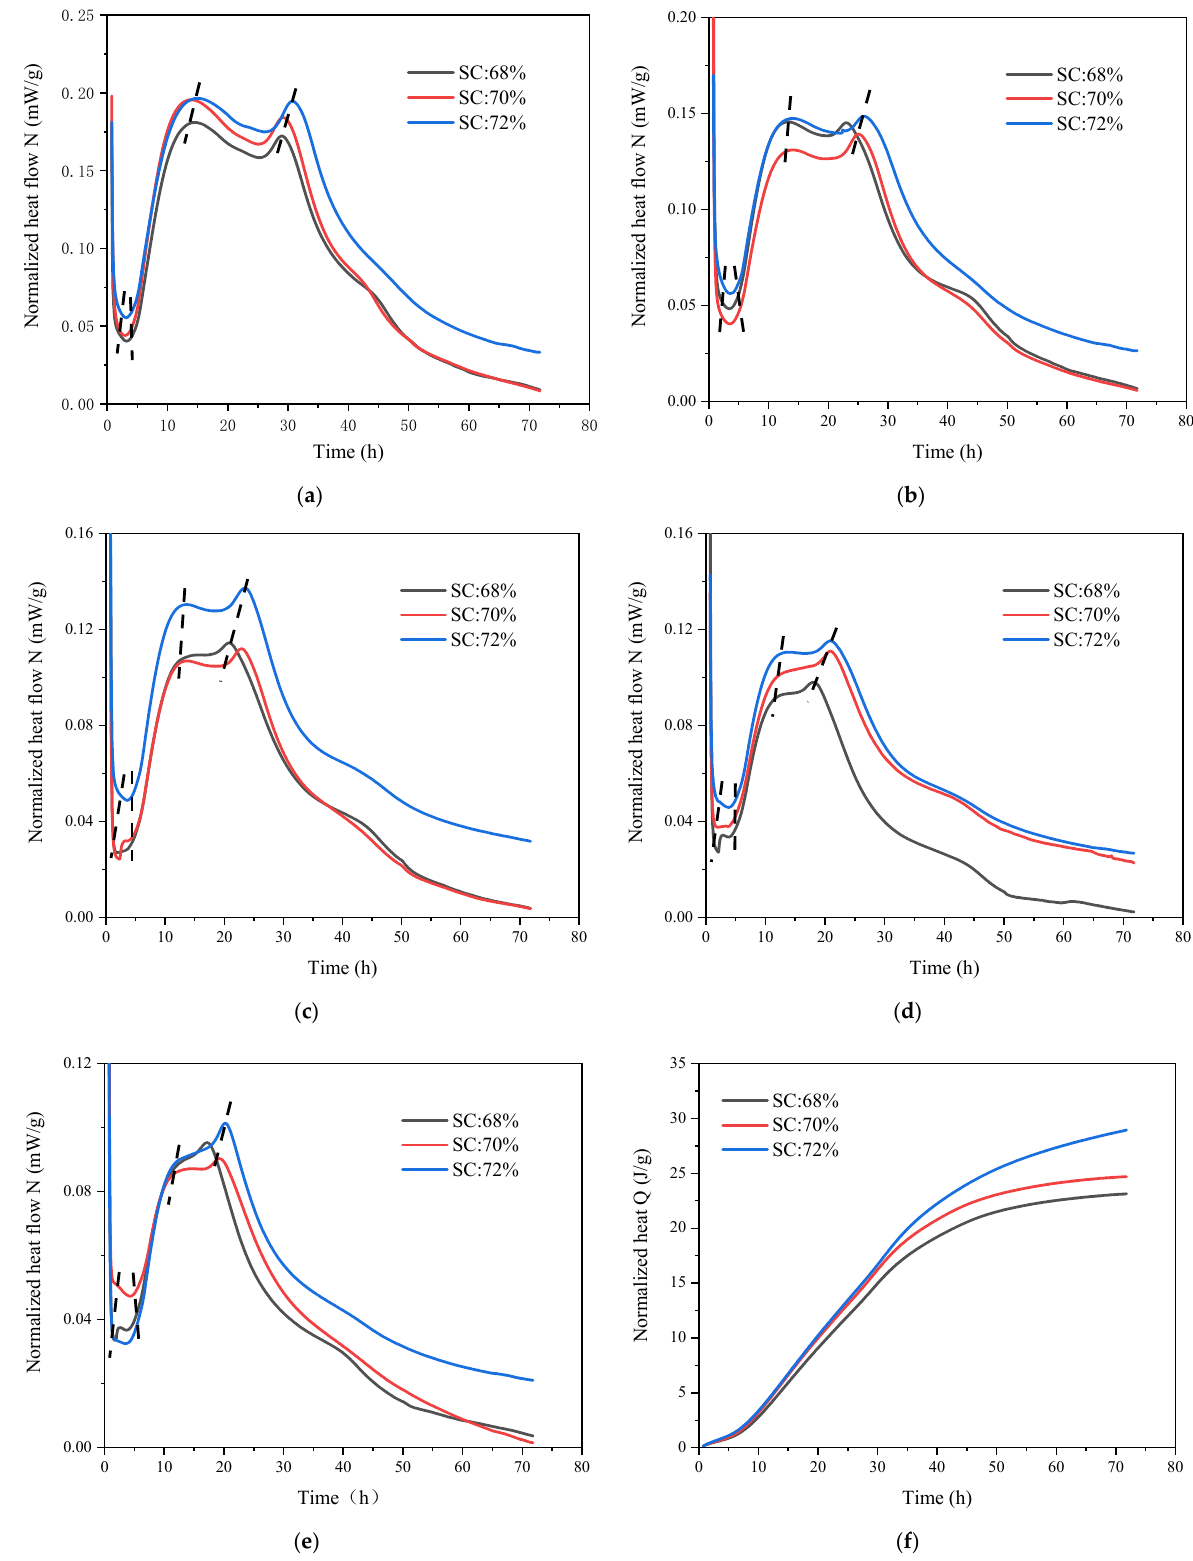
Figure 6. Hydration heat release rate curve: ( a ) TCR = 4, ( b ) TCR = 6, ( c ) TCR = 8, ( d ) TCR = 10, ( e ) TCR = 12 and total heat release: ( f ) TCR = 4 of CSTB under different Table 4. Time of hydration exothermic phase of different SCs.